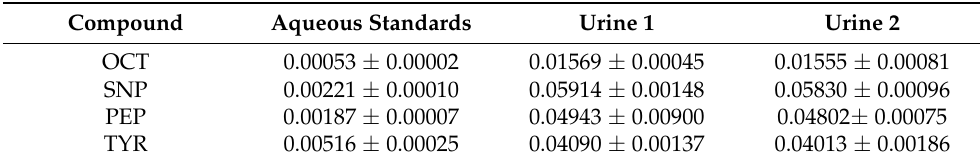
Table 2. Slopes a of standard additions’ calibration graphs (L µ g − 1 ).